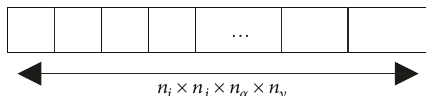
Figure 2: Chromosome